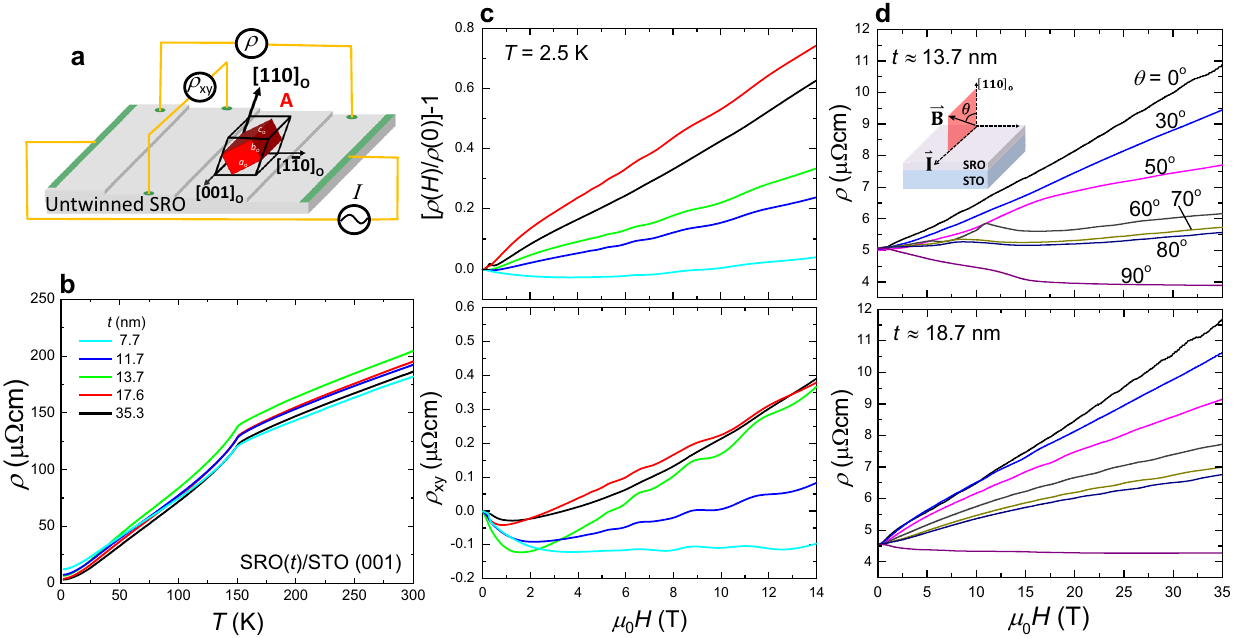
Fig. 2 The temperature and fi eld dependence of ρ and ρ xy in SRO thin fi lms. a An illustration of the measurement geometry for ρ and ρ xy with respect to the SRO crystalline axes. b The T dependent ρ in SRO( t )/STO (001) with thicknesses t s ranging from about 7.7 – 35.3 nm. The kink at T ≈ 150 K corresponds to the onset of the ferromagnetism. The upper panel and lower panel of c show the MR and ρ xy , respectively, as a function of fi eld at T = 2.5 K, and they share the same color codes as that in ( b ). Pronounced quantum oscillations were observed for ≥ 3.5 T in all fi ve SRO fi lms with different t values. d The θ dependent MR for t ≈ 13.7 and 18.7 nm are shown in the upper panel and lower μ 0 H panel, respectively. The inset cartoon shows the de fi nition of the θ angle. For the fi eld perpendicular to the fi lm surface plane ( θ = 0 o ), a large and positive MR was observed, which is practically linear with the fi eld strength up to 35 T without saturation. The magnitude of the positive MR drops with increasing θ , and it becomes a negative MR when the fi eld is applied along the current direction ( θ = 90 o